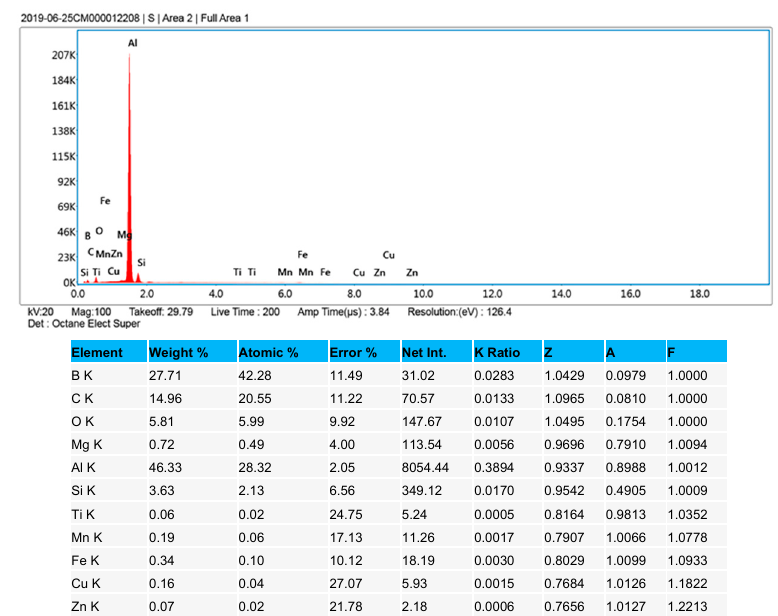
Figure 6. SEM and EDX test results of a cubic sample with mixed B 4 C (20 wt%) and AlSi10Mg (80 wt%).